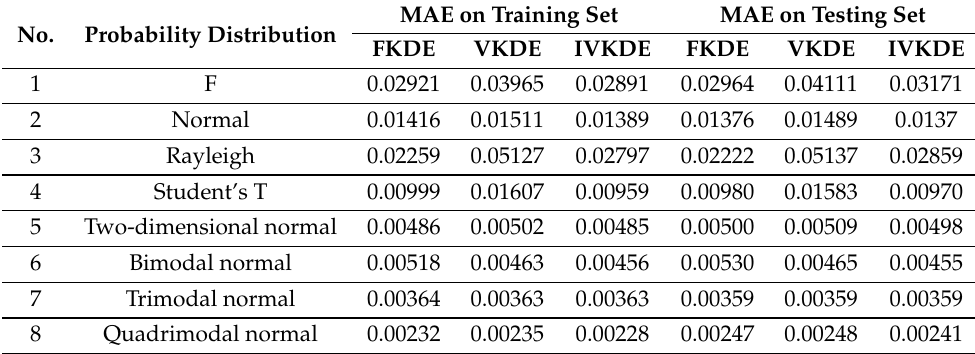
Table 3. Competitive results among FKDE, VKDE, and IVKDE on 8 different probability